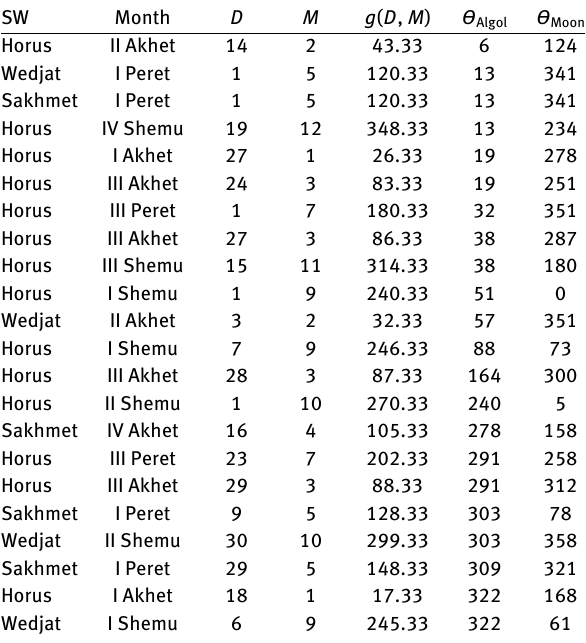
Table 1. “GGG” prognosis texts mentioning Horus, Wedjat or Sakhmet. The columns are SW (Selected word), ancient Egyptian month (“Month”), day ( D ), numerical month value ( M ), time point ( g ( D , M )) and the phase angles ( Θ Algol and Θ Moon ). All values are in the order of increasing Θ Algol , because this allows an easy compari- son with the results shown in List 1 and Figure 1.